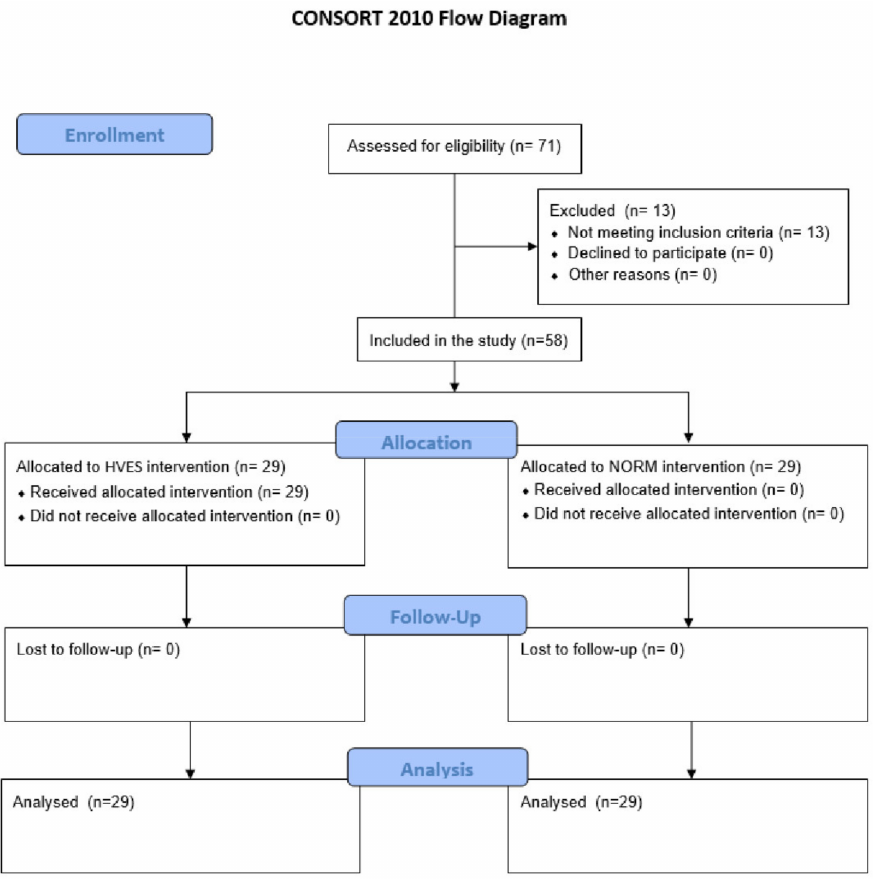
Figure 2. The CONSORT 2010 flow diagram of patients in the study. Abbreviations: HVES, high- voltage electrical stimulation; NORM, control